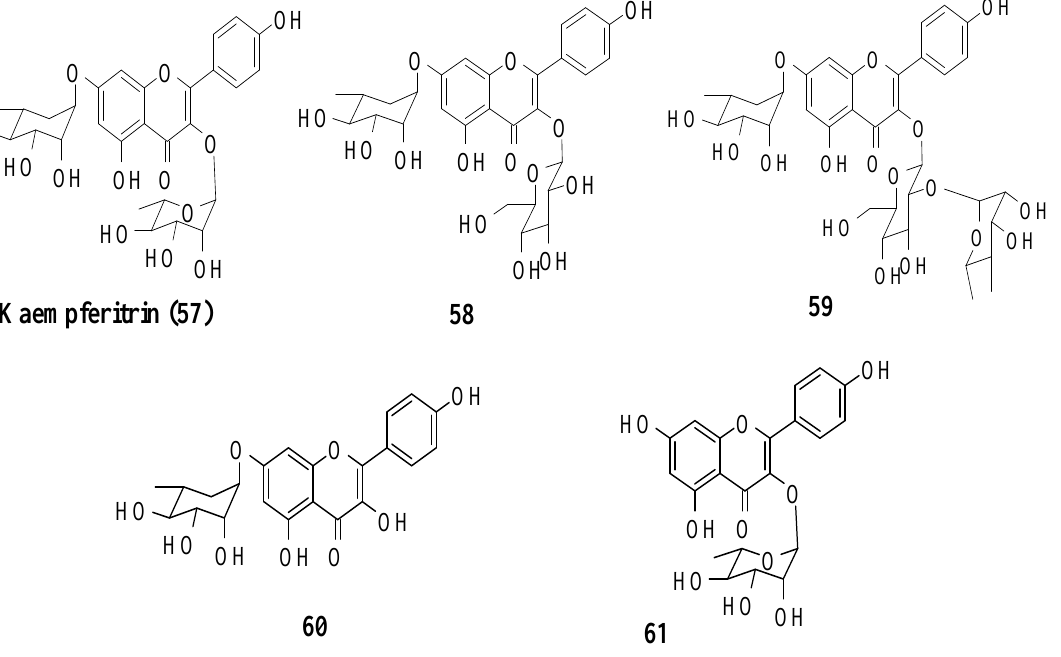
Figure 16. The structures of flavonoids isolated from S. dendroideum [53]. Proença et al. evaluated the series of 40 flavonoids for an in vitro α -glucosidase inhibition. The compounds were grouped into five groups [54]. After testing all the compounds’ α -glucosidase inhibitory activity against acarbose, the authors created a pattern